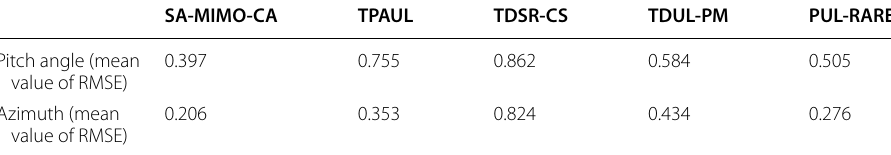
Table 4 Relationship between pitch angle, azimuth angle and the number of